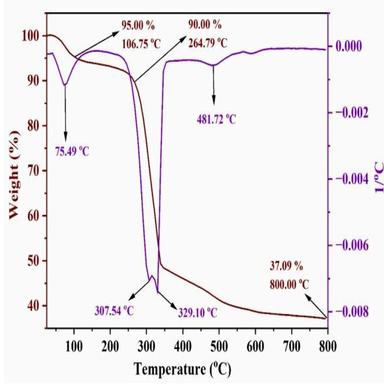
TGA and DTA plots of the Ti-TPA-Si-C.